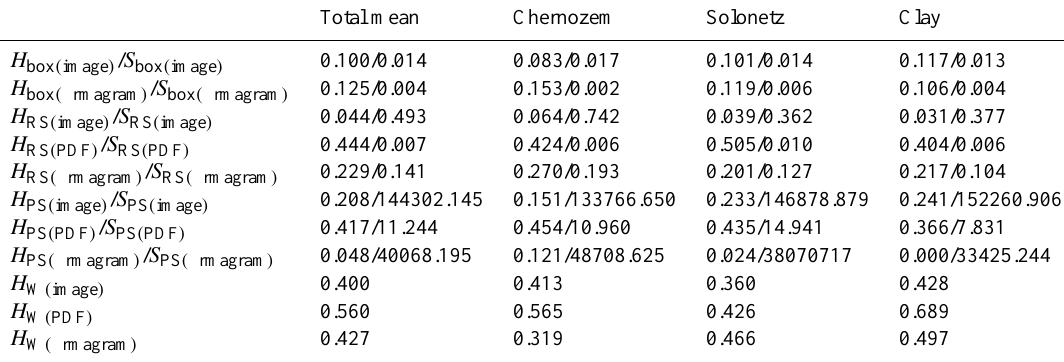
Table 5. Hurst exponent ( H ) and standard deviation ( S ) for each soil type and measurement technique used.